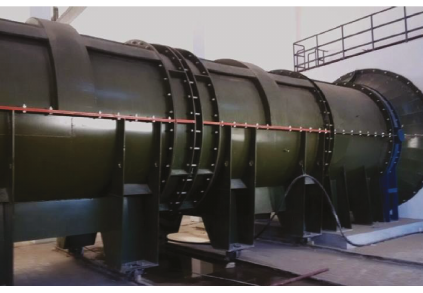
Figure 1: The view of the contrarotating axial fan. Table 1: Design parameters of the contrarotating axial